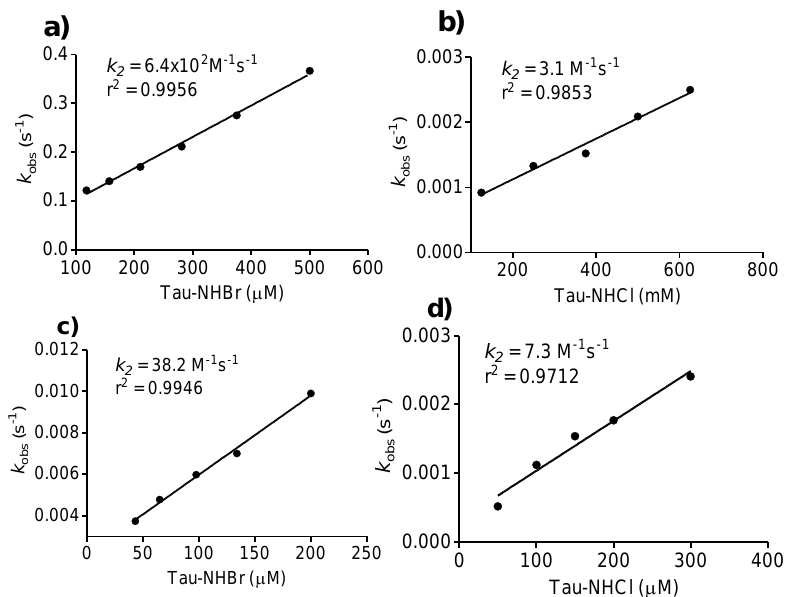
Figure 7. Tau-NHBr versus TauNHCl as oxidants of tetramethylbenzidine and curcumin. ( a,b ) Determination of bimolecular rate constant ( k 2 ) for the reaction between TMB and Tau-NHBr or Tau- NHCl. The reaction mixture was composed of 1.4 mM TMB and increasing concentrations of haloamines in 50 mM phosphate buffer, pH 7.0; ( c,d ) Determination of the bimolecular rate constants ( k 2 ) for the reactions between curcumin and Tau-NHBr or Tau-NHCl. The reaction mixture was composed of 10 µM curcumin and increasing concentrations of haloamines in 50 mM phosphate buffer, pH 7.0.